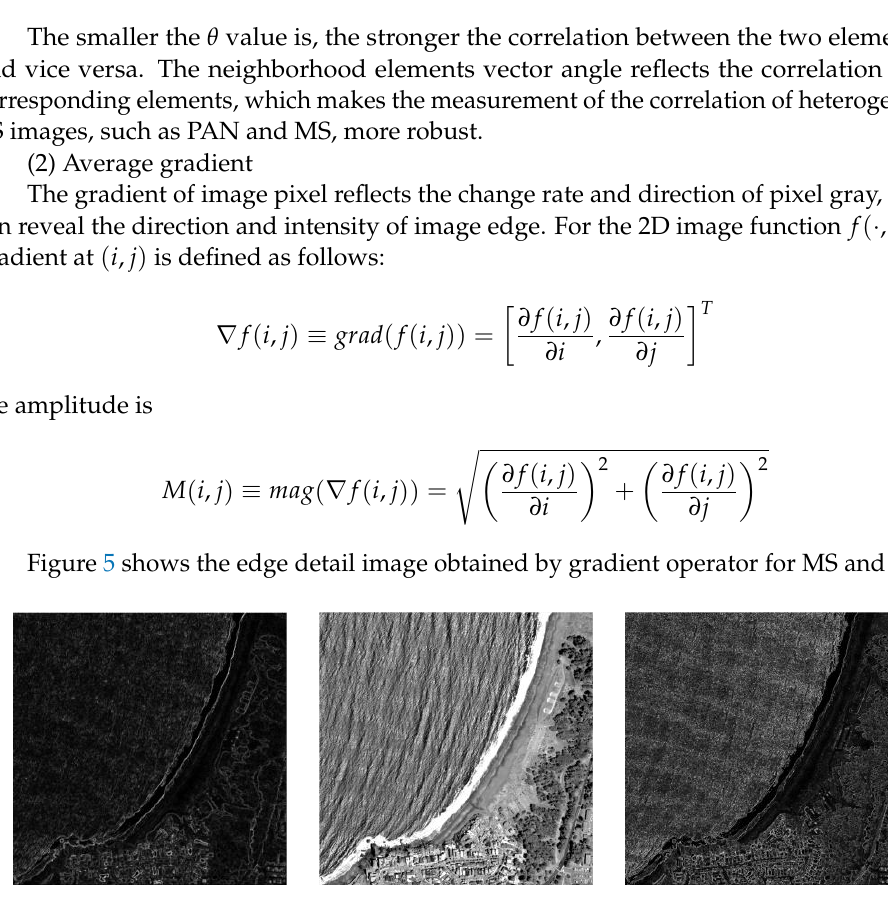
Figure 5. The gradient edge detail images of MS and PAN. ( a ) MS. ( b ) MS gradient edge detail. ( c ) PAN. ( d ) PAN gradient edge detail.